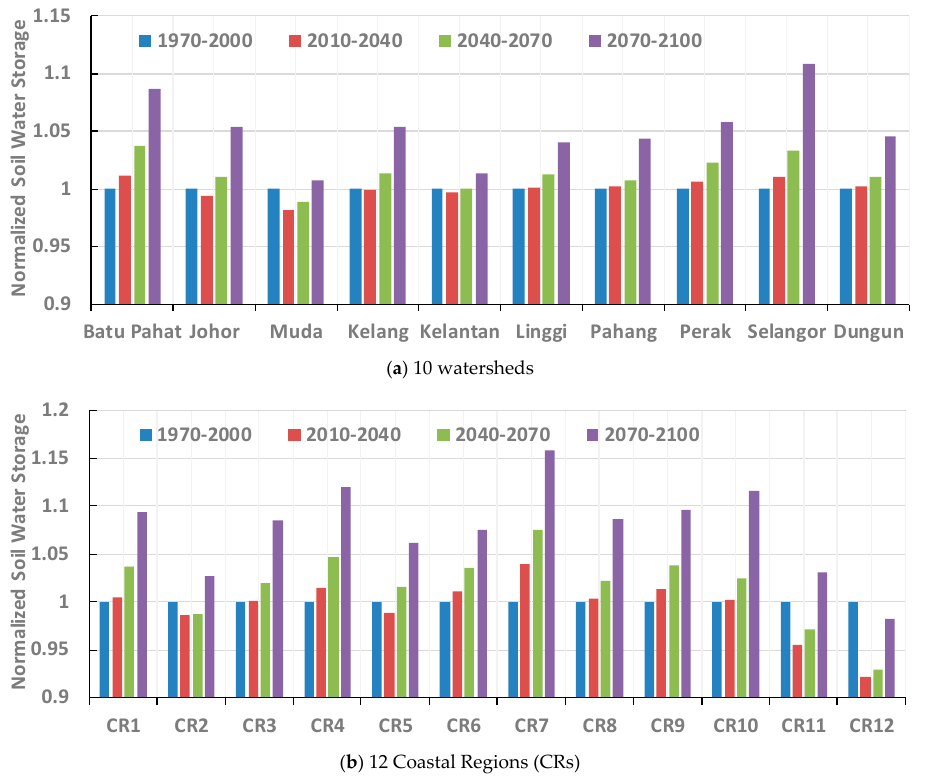
Figure 9. Normalized values of 30-year mean of the basin-average annual mean soil water storage during the historical period (1970 − 2000) and through the 21st century for the a) 10 watersheds, and b) 12 coastal regions in Peninsular Malaysia. 30-year mean of the basin-average annual mean soil water storage values are normalized by the values of the 1970 − 2000 period. ( a ) 10 watersheds; ( b ) 12 Coastal Regions